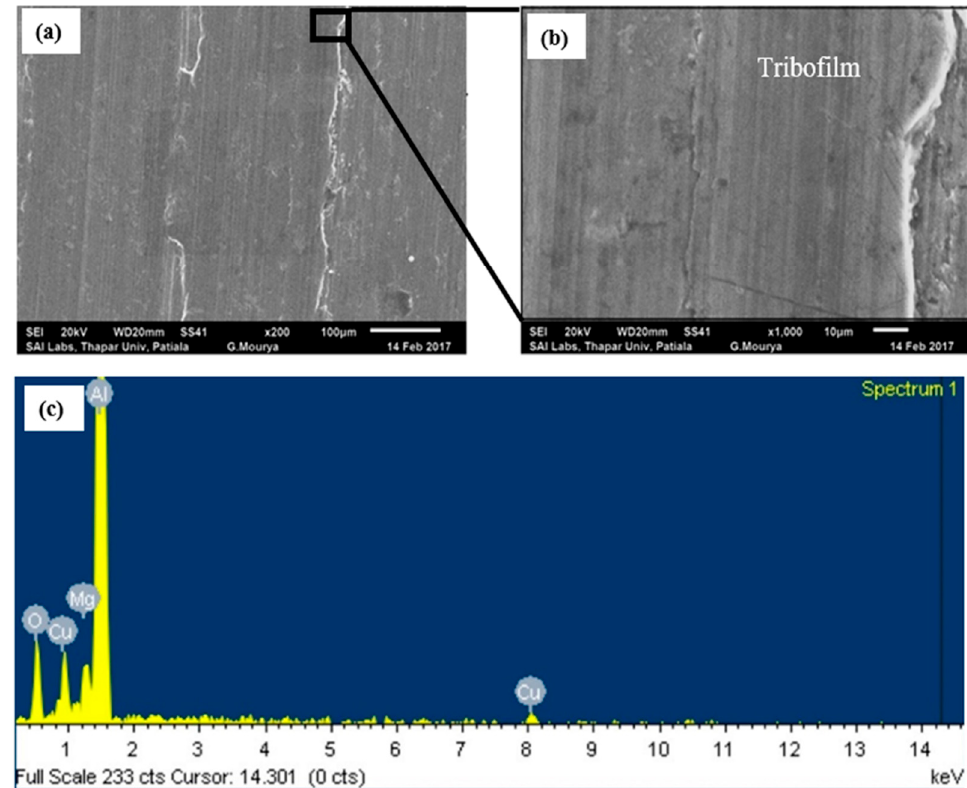
Figure 5. ( a ) SEM image of worn surface of the aluminium alloy disc lubricated with PAO + CuO nanolubricant at 50 N load (200×); ( b ) magnified image (1000×) of Figure 5a; and ( c ) EDS spectrum of Figure 5a. Worn surface is relatively smooth with tribofilm formation.